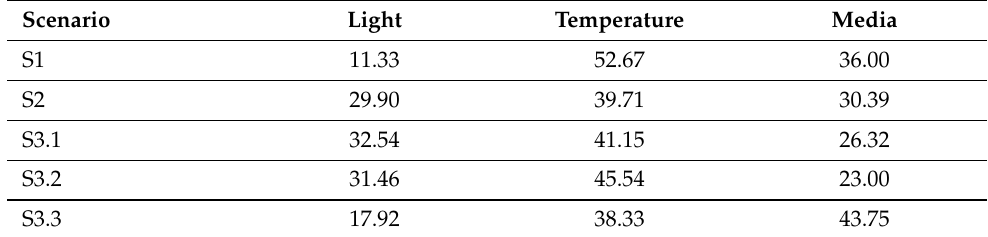
Table 5. Slot filling—error distribution in